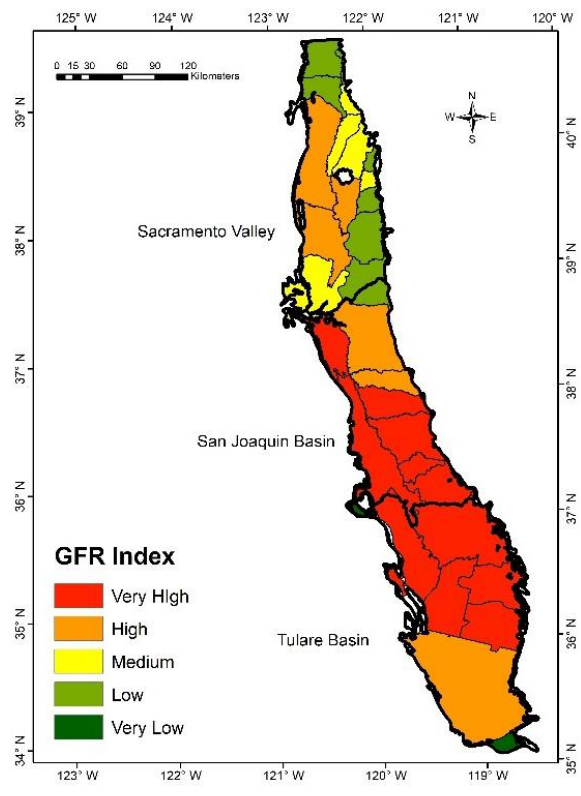
Figure 17. GFR Susceptibility Index.